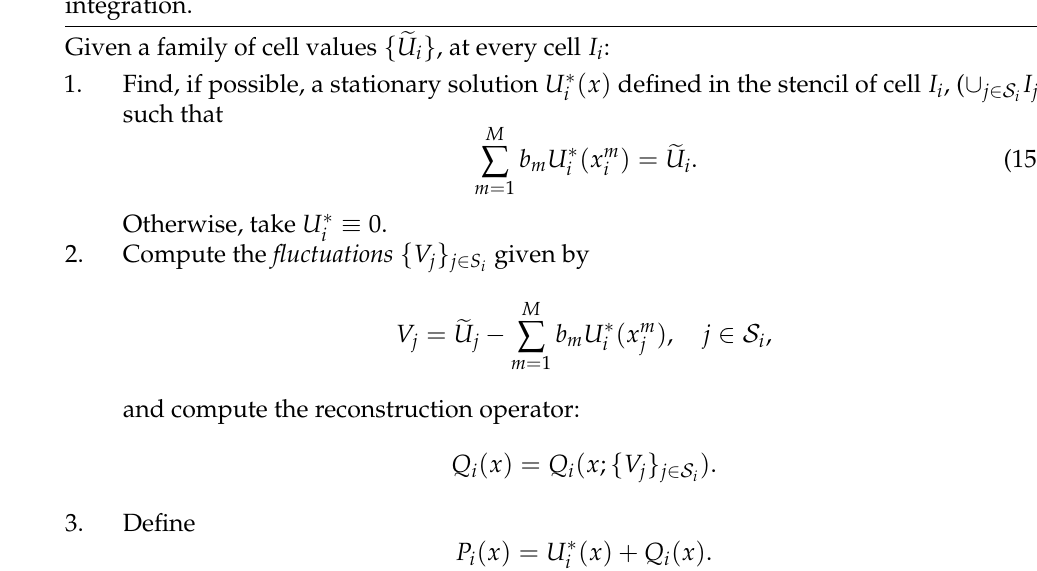
Algorithm 2 Exactly well-balanced methods. Reconstruction procedure using numerical